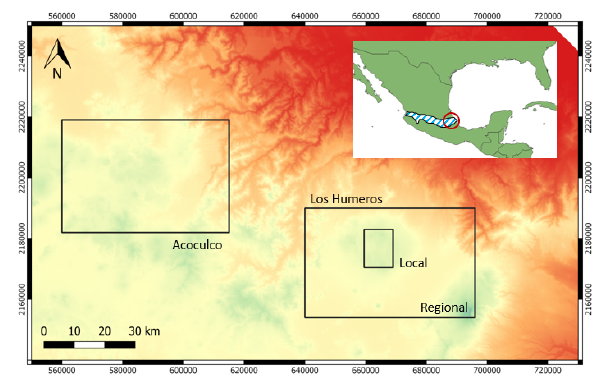
Figure 1. The investigated sites, Los Humeros and Acoculco, are located east of Mexico City in the Trans-Mexican Volcanic Belt (TMVB, dashed blue area). Acoculco is modelled at regional scale. Los Humeros is modelled at regional and local scales. Area loca- tions are shown on the Digital Elevation Model SRTM 90m. Coor- dinate system is WGS84/UTM zone